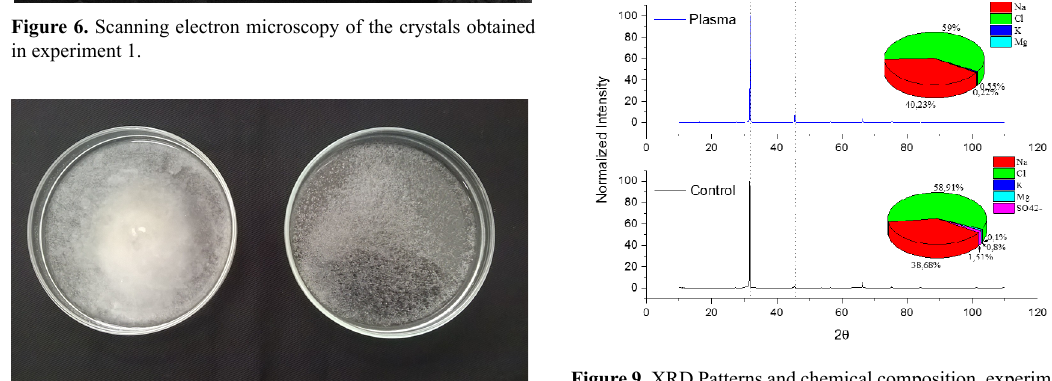
Figure 9. XRD Patterns and chemical composition, experiment 2.